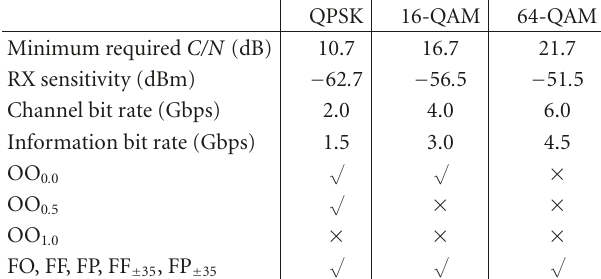
Table 6: OFDM system